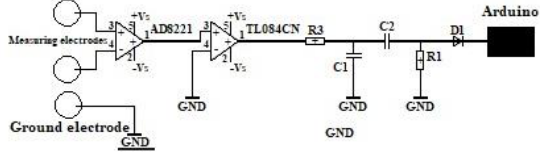
Fig. 3. Diagram of the designed EMG sensor [5].